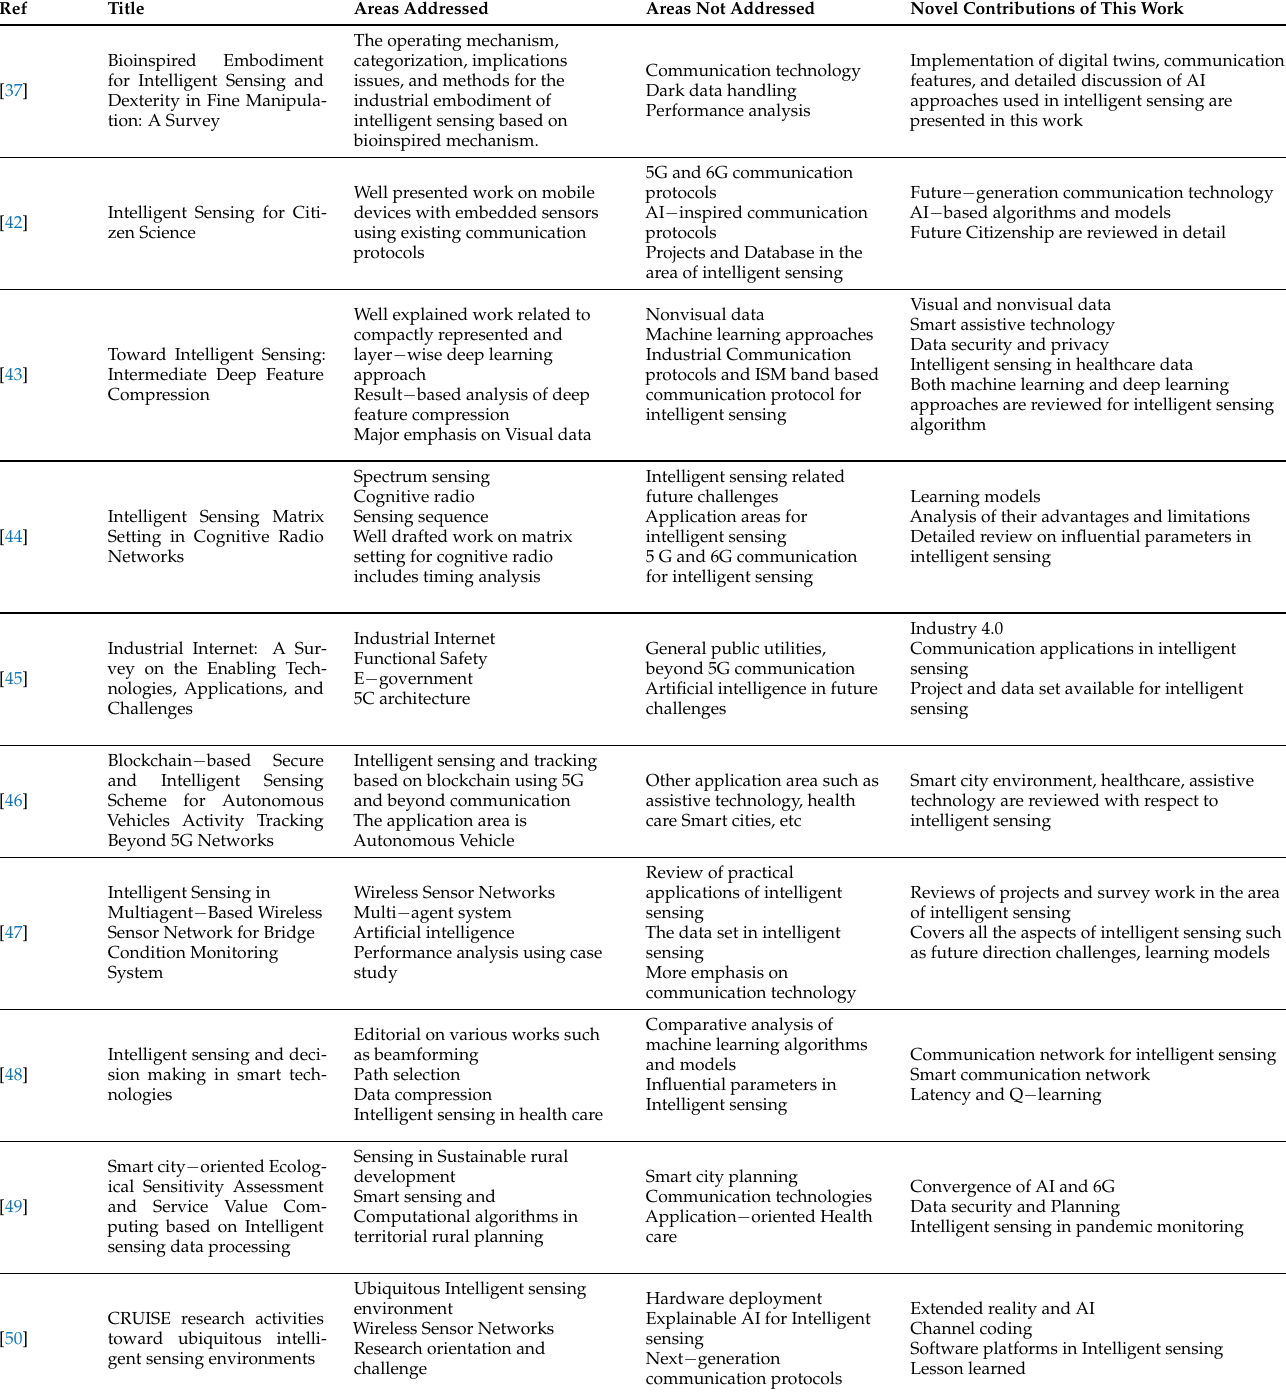
Table 2. Comparative Analysis of Work Available in the Area of Intelligent Sensing and Contributions Presented in This